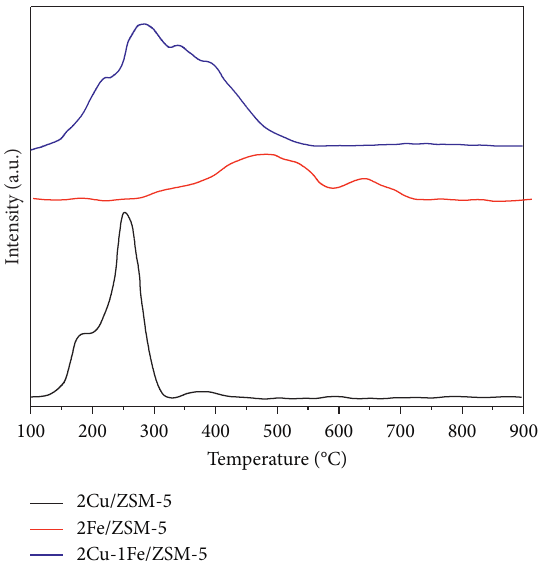
Figure 6: H 2 -TPR profiles of catalyst